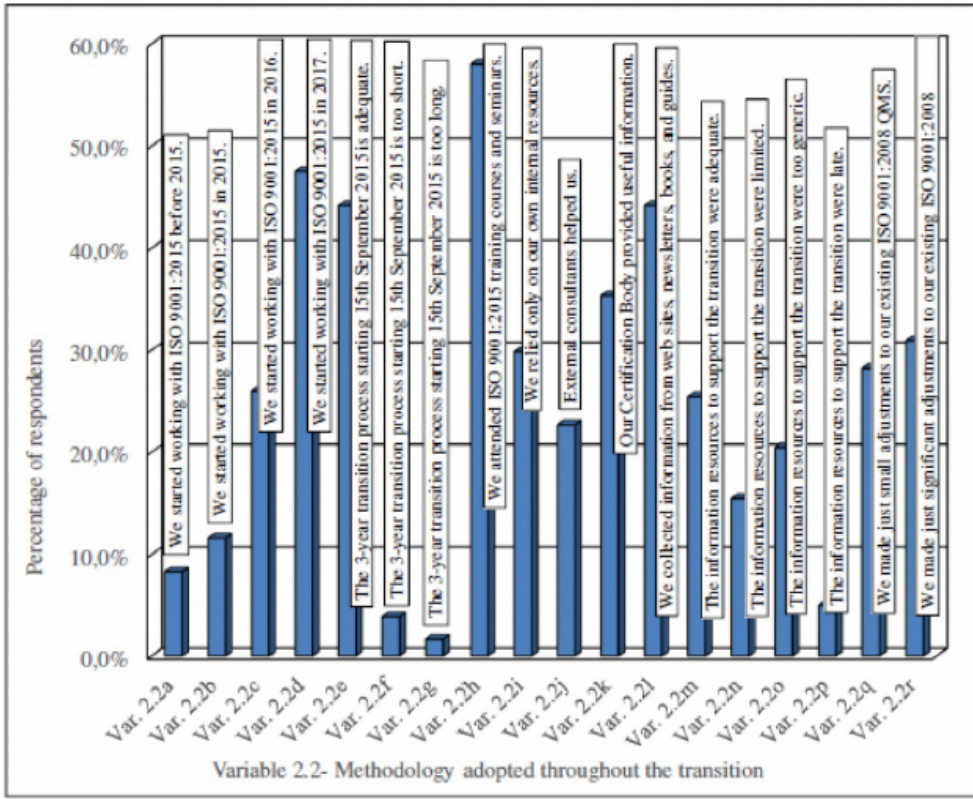
Figure 1. Methodology adopted by the organization concerning the ISO 9001:2015 transition process (% of